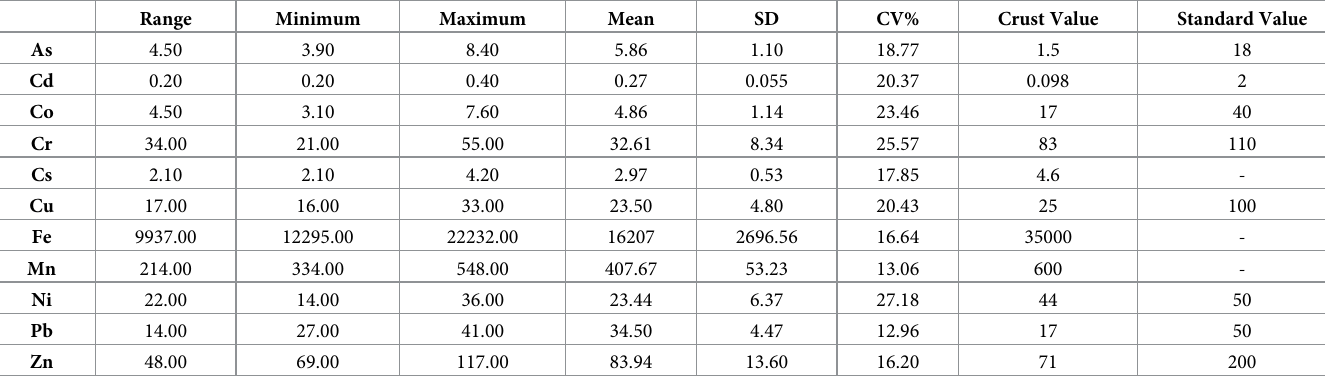
Table 2. Descriptive statistics of heavy metal concentrations in urban soils of Yazd city, crust values [23] and Iran standard value [37] (mg � kg -1 ).